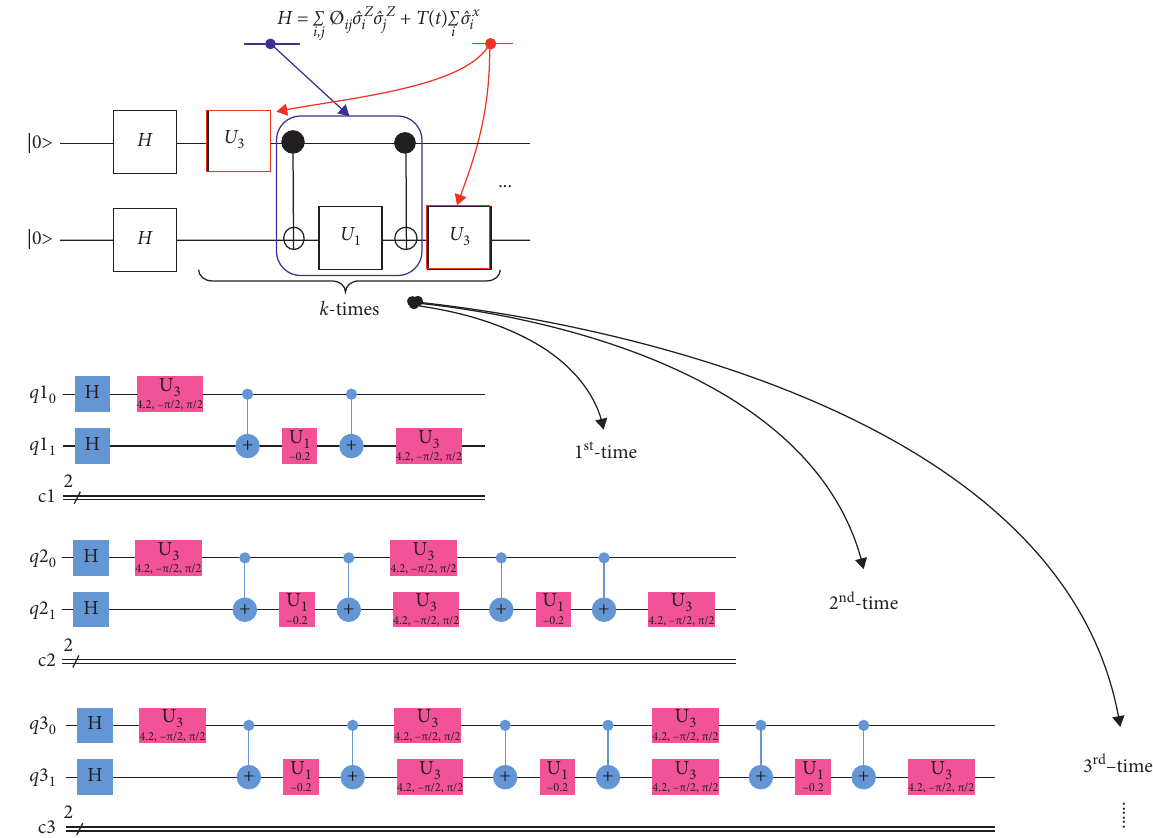
Figure 3: Quantum circuit architecture for implementing adiabatic quantum annealing. (a) Respective quantum gate corresponding the unitary operator of U zz ( S ) and U x ( S ) . The lower part illustrates the Suzuki–Trotter iteration to search the ground state energy of Hamiltonian H i i stands for the i th